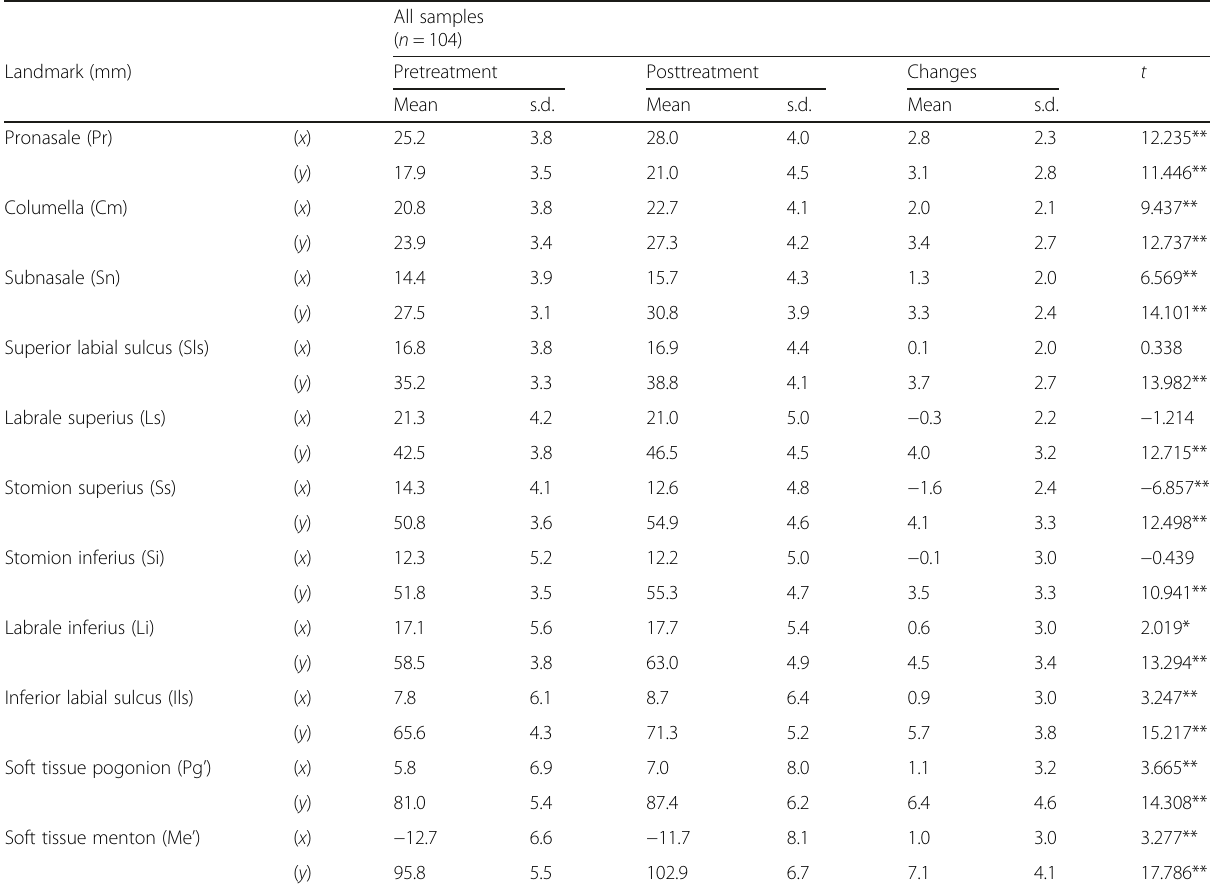
All samples ( n = 104)